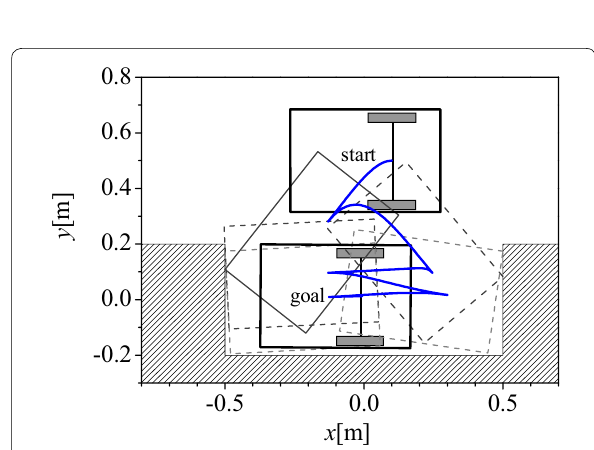
Fig. 7 Numerical simulation result when α is switched as α 1 0.5 8 1 = → → →